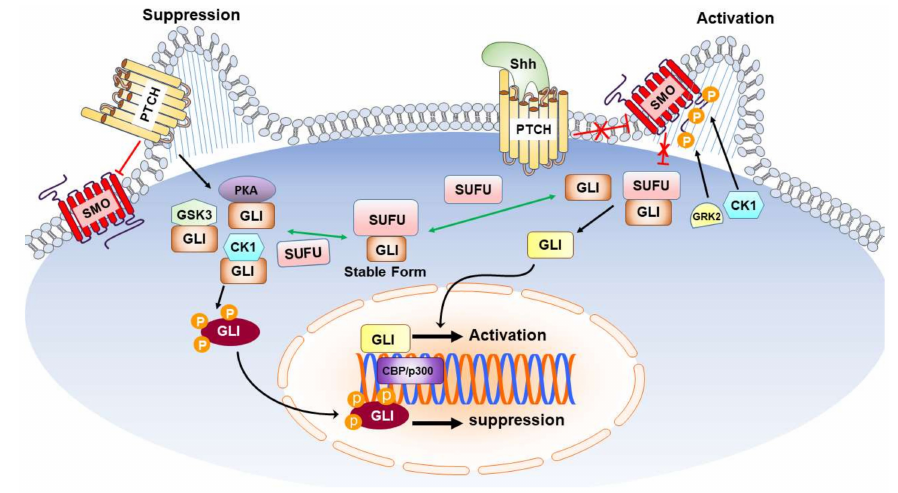
Figure 1. Sonic Hedgehog Signal Transduction Pathways. Shh acts on PTCH to relieve the inhibitory of PTCH on SMO, thereby activating the downstream pathway of SMO via binding with COS2. Upon binding of SMO to COS, Fu is released from COS2 complex and the freed Fu binds to SUFU to release GLI from SUFU complex. The freed GLI then enters the nucleus and, along with other transcription factors such as CBP/p300, binds to the promoters of target genes to regulate their expression. Black arrows indicate promotion or increasing; red lines with a “T” and/or “X” indicate inhibition, suppression, or decreasing; green arrows indicate competition. Abbreviation: Shh: Sonic Hedgehog; PTCH: Patched; SMO: Smoothened; CBP: CREB-binding protein; COS2: Costal-2; Fu: protein Fused; SUFU: Suppressor of